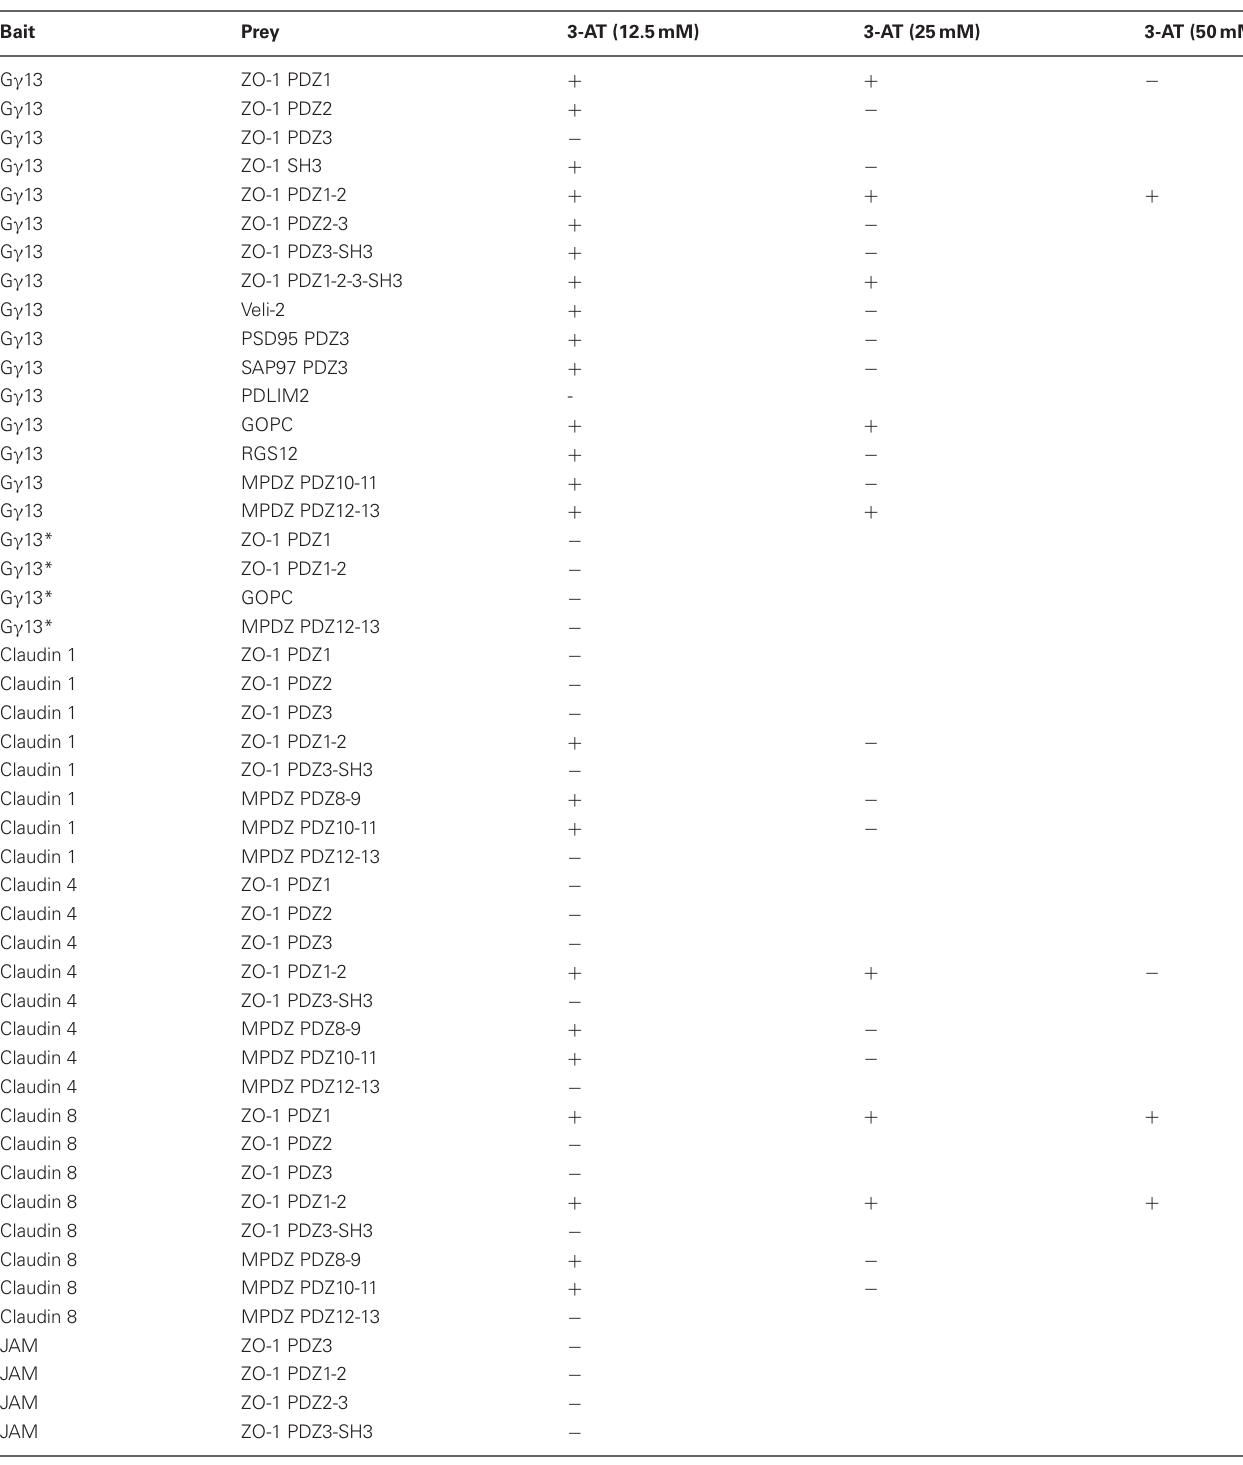
Table A2 | Table summarizing the results (from at least three independent experiments) of the yeast two-hybrid interaction assays performed with different combinations of baits and